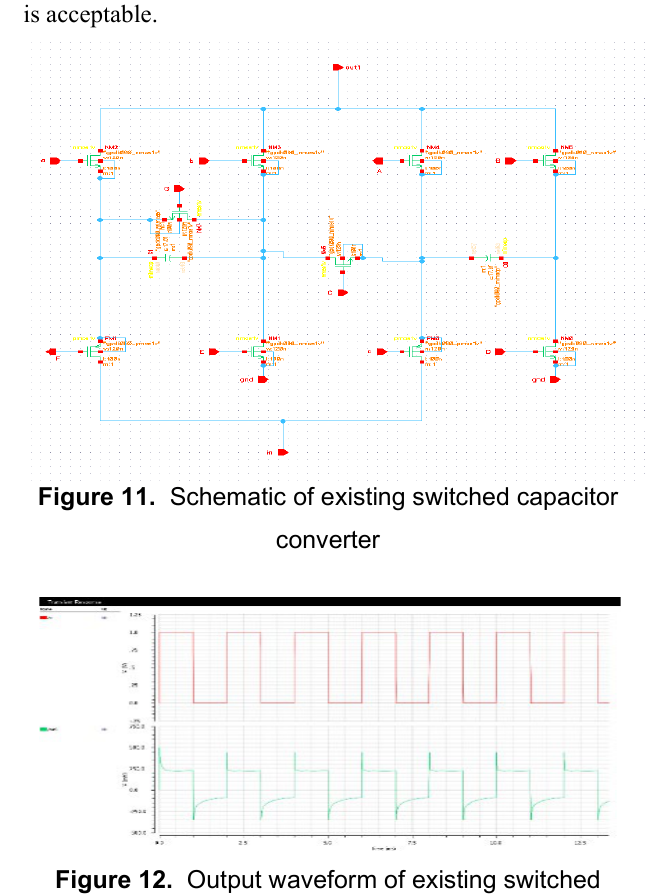
Figure 12. Output waveform of existing switched capacitor converter